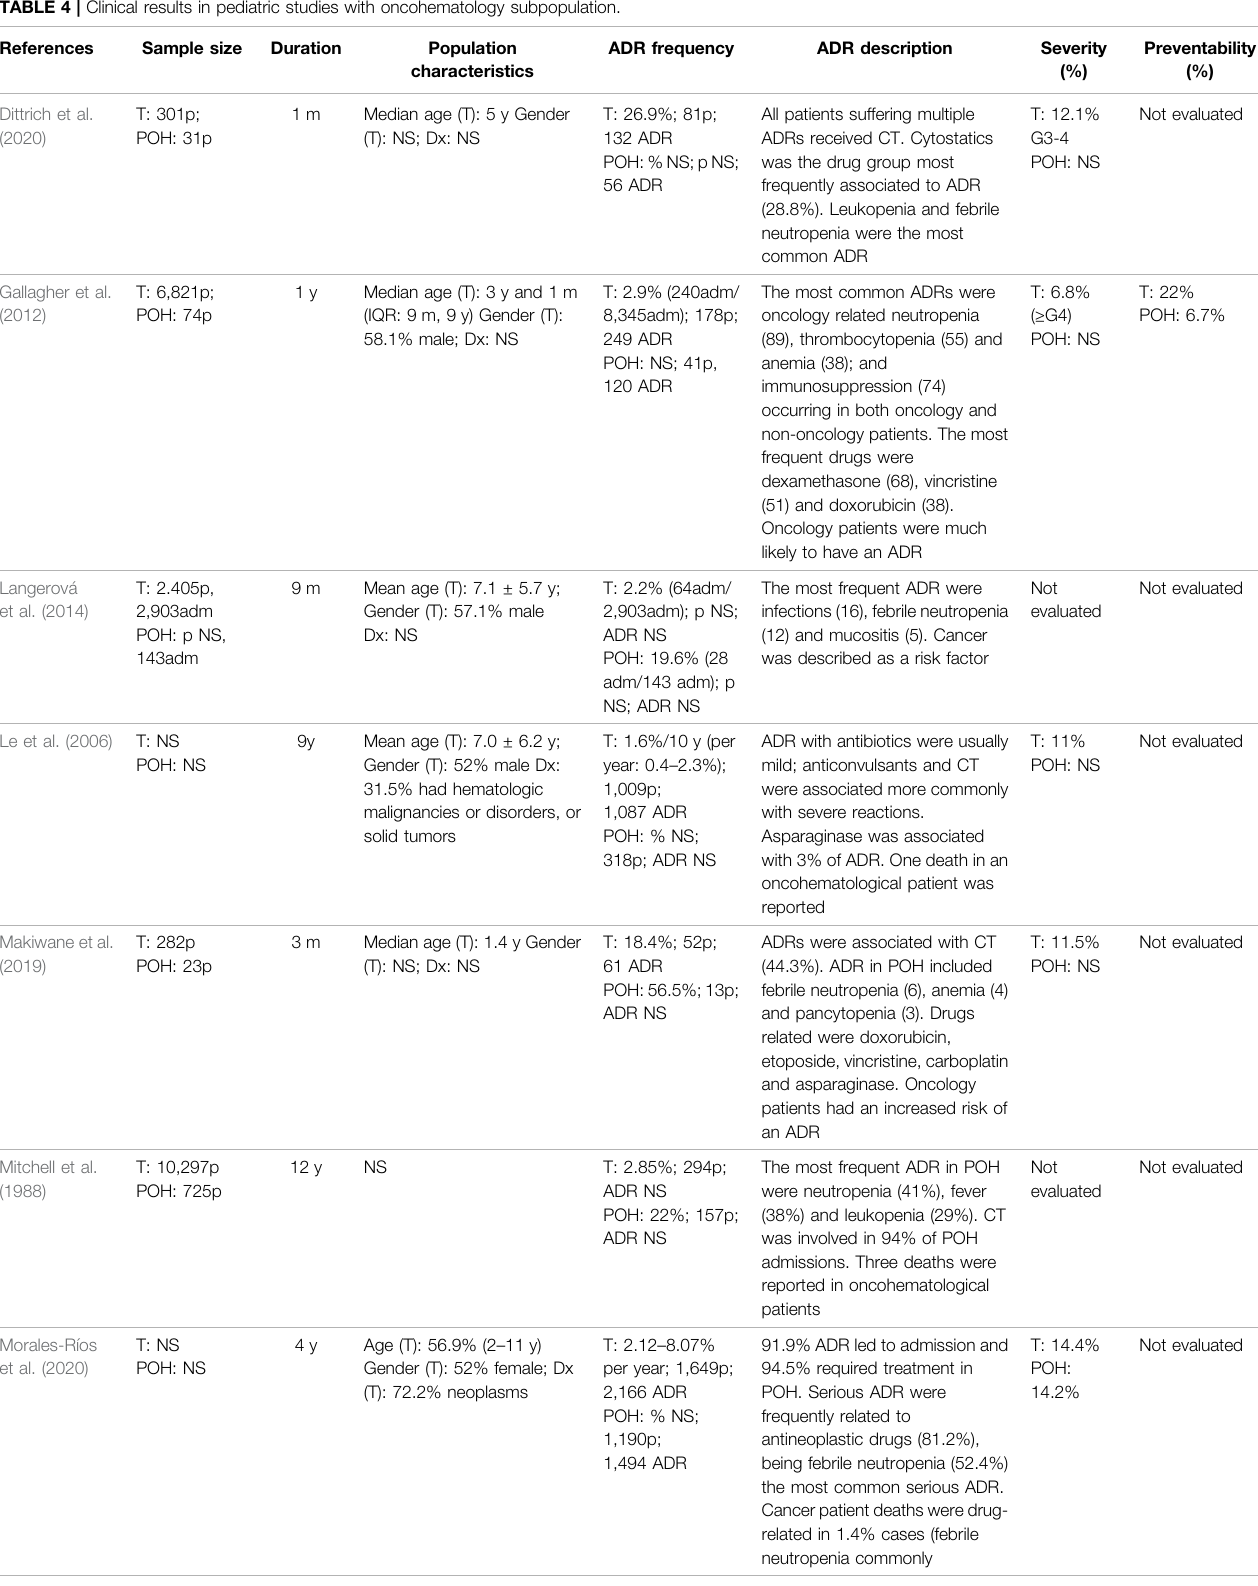
TABLE 4 | Clinical results in pediatric studies with oncohematology